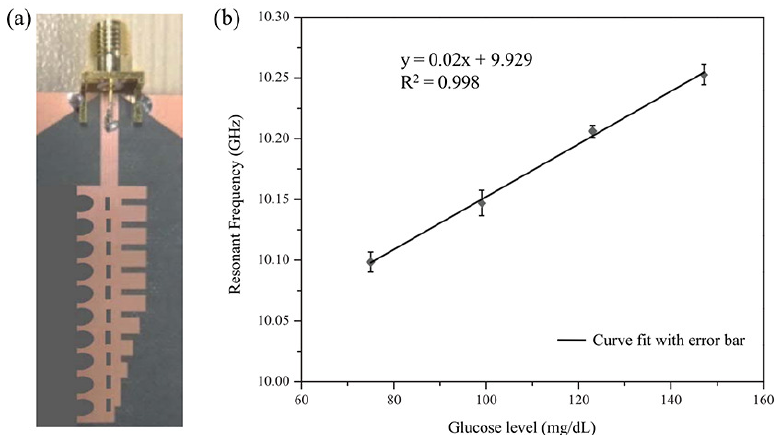
Figure 10. Glucose concentration detection using an SSPP endfire sensor. ( a ) Configuration of the sensor. ( b ) Change in the resonant frequency with the glucose concentration from 70 mg/dL to 150 mg/dL (Reprinted with permission from [85]; © 2021 IEEE).